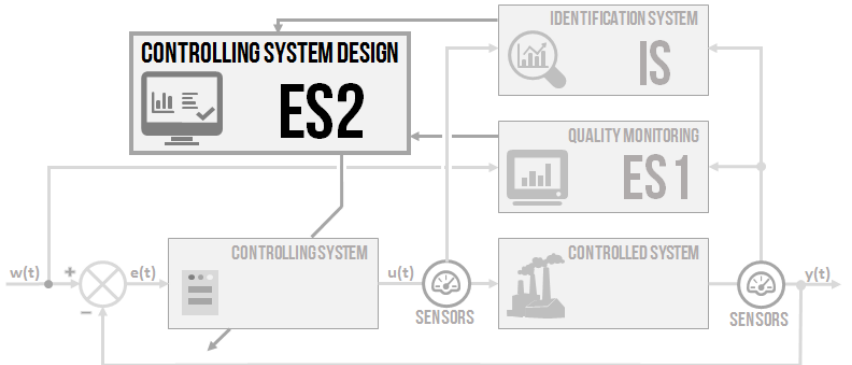
Figure 9. The schema of the concept of intelligent controlling system with outlined block of the controller parameters design system.